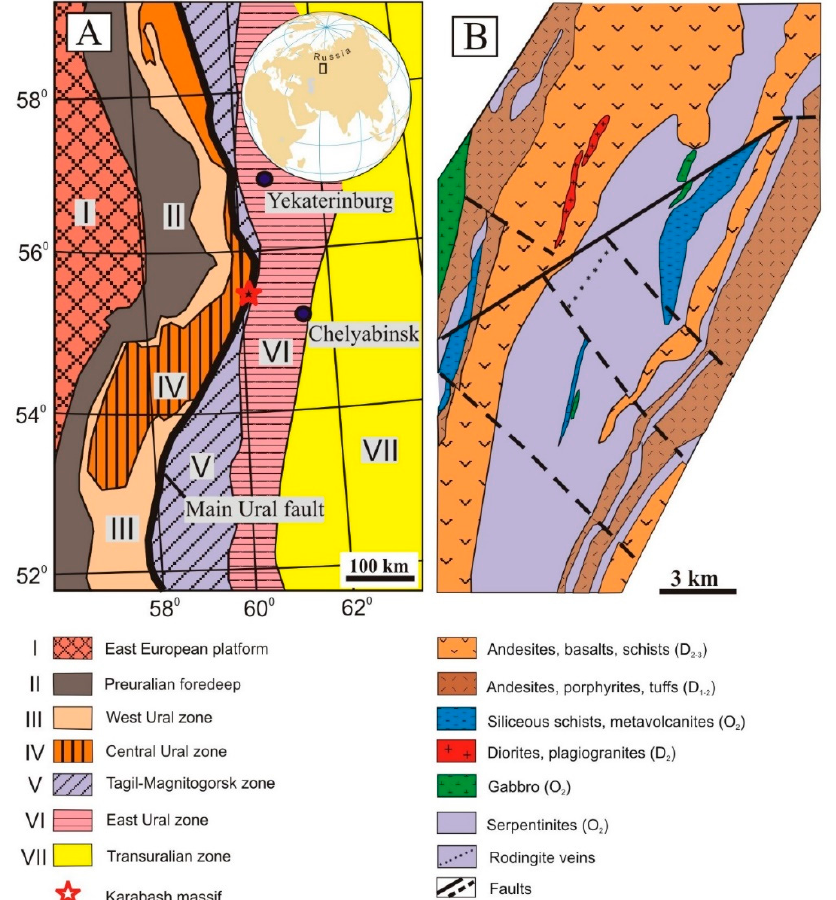
Figure 1. Karabash ultramafic massif (Southern Urals, Russia). ( A ) Position of the Karabash massif on the tectonic scheme of Urals per Puchkov [1]. ( B ) Schematic geological map of the Karabash massif (modified from Snachyov et al. [2] with authors’ additions).